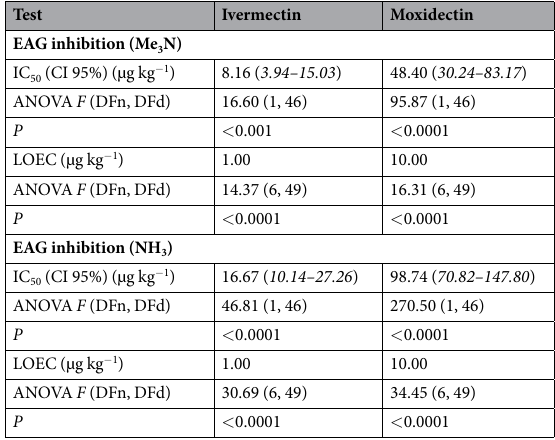
Table 1. Concentrations of IVM and MOX where the antennal response of adults of Scarabaeus cicatricosus is inhibited by half (IC 50 ) (95% CV intervals), calculated from dose-response curves presented in Fig. 2, and lowest significant observed effect concentration (LOEC) reported from Dunnet’s tests performed in the ANOVA-GLM